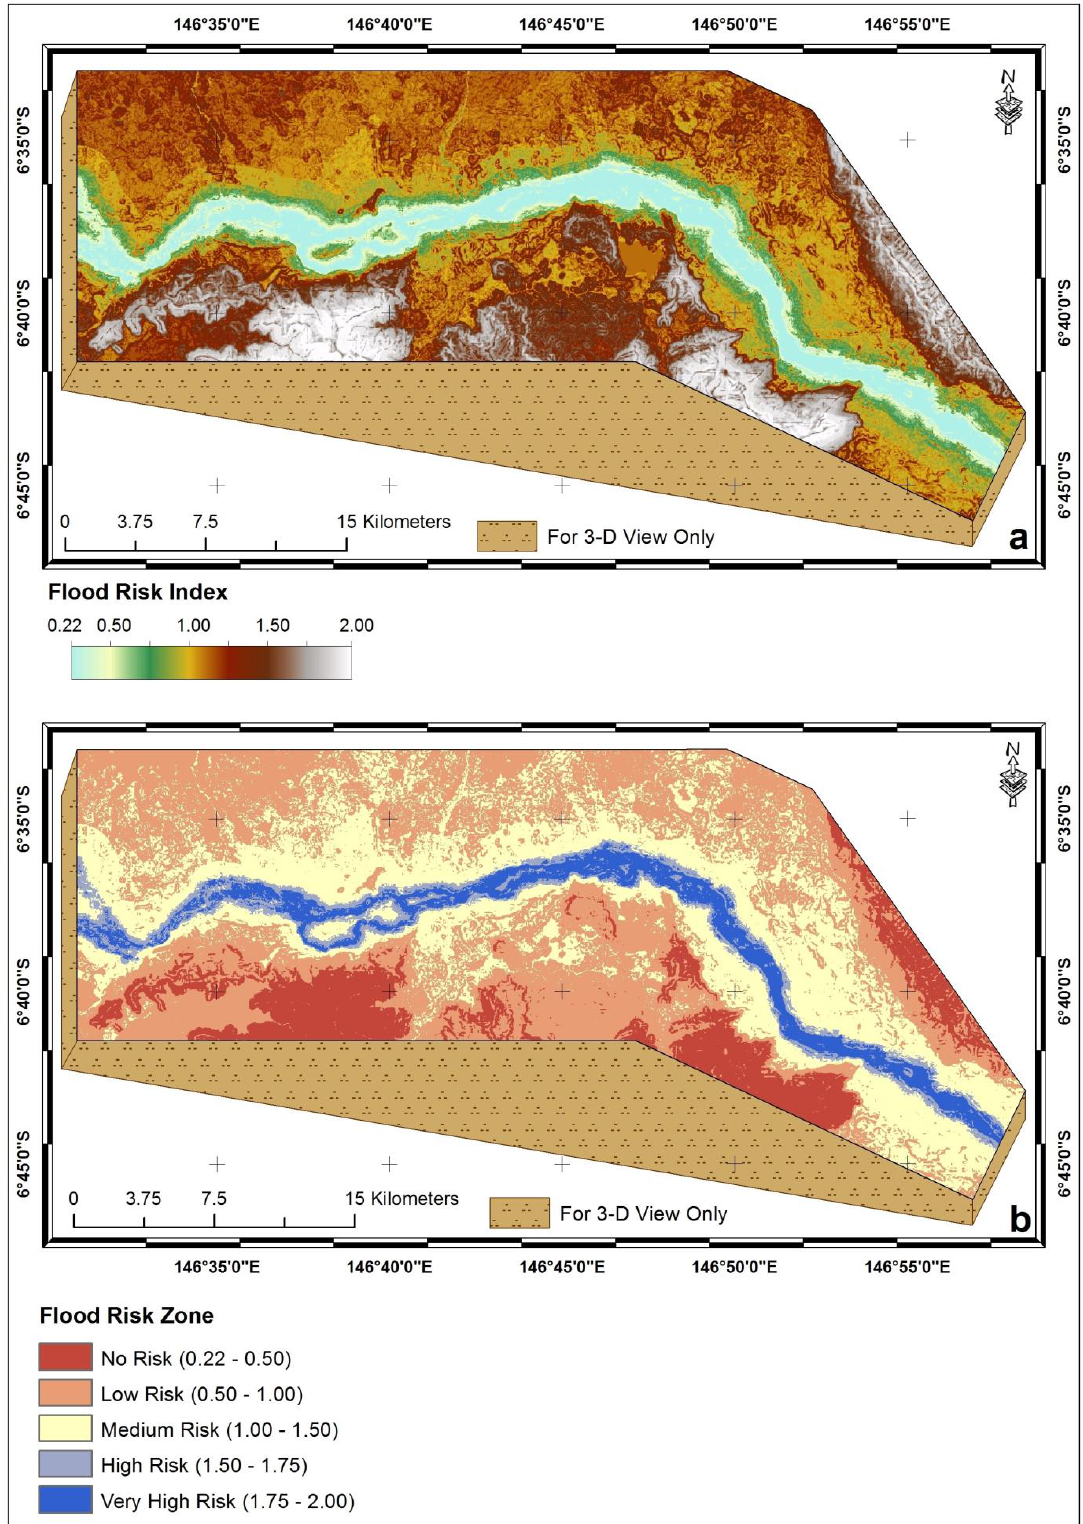
Figure 4. Flood risk analysis map based MCDA- resulted flood risk index ( a ) and classified flood risk zones ( b ).